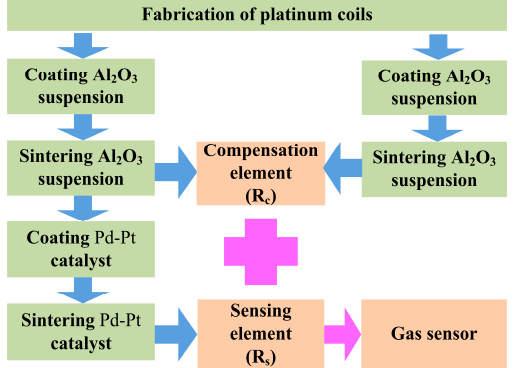
Figure 5. Manufacturing process of the catalytic gas sensor.